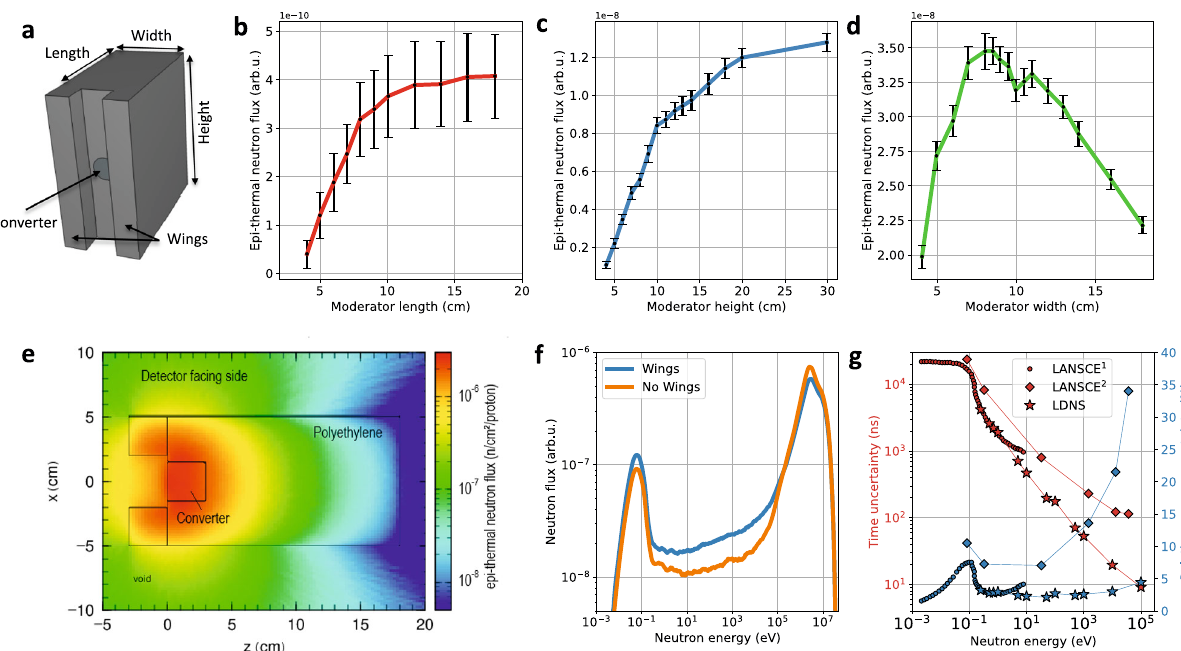
Fig. 2 Optimization of the epithermal neutron fl ux from the moderator. a Sketch of the moderator geometry. b – d Epithermal (1 – 10 eV) neutron fl ux from a PHITS simulation at the detector position as a function of moderator dimensions. A moderator with 17 × 20 × 10 cm 3 was chosen for the experiment. Error bars are the result of statistical uncertainties in the simulation and represent one standard deviation. e Epithermal fl ux distribution in the horizontal plane simulated with the measured neutron fl ux from Fig. 1d (p on LiF). Most epithermal neutrons are emitted in the vicinity of the converter. f Simulated neutron fl ux at the detector with and without the moderating wings. The wings drastically improve moderation ef fi ciency. g (red) Simulated ToF uncertainty caused by the moderation for this LDNS moderator design in comparison to simulations for the LANSCE 31,32 spallation source. (blue) Resulting energy uncertainty at 1.8 m distance for both source types. Moderated LDNS have shorter pulse lengths than conventional neutron sources enabling shorter ToF distances for the same energy